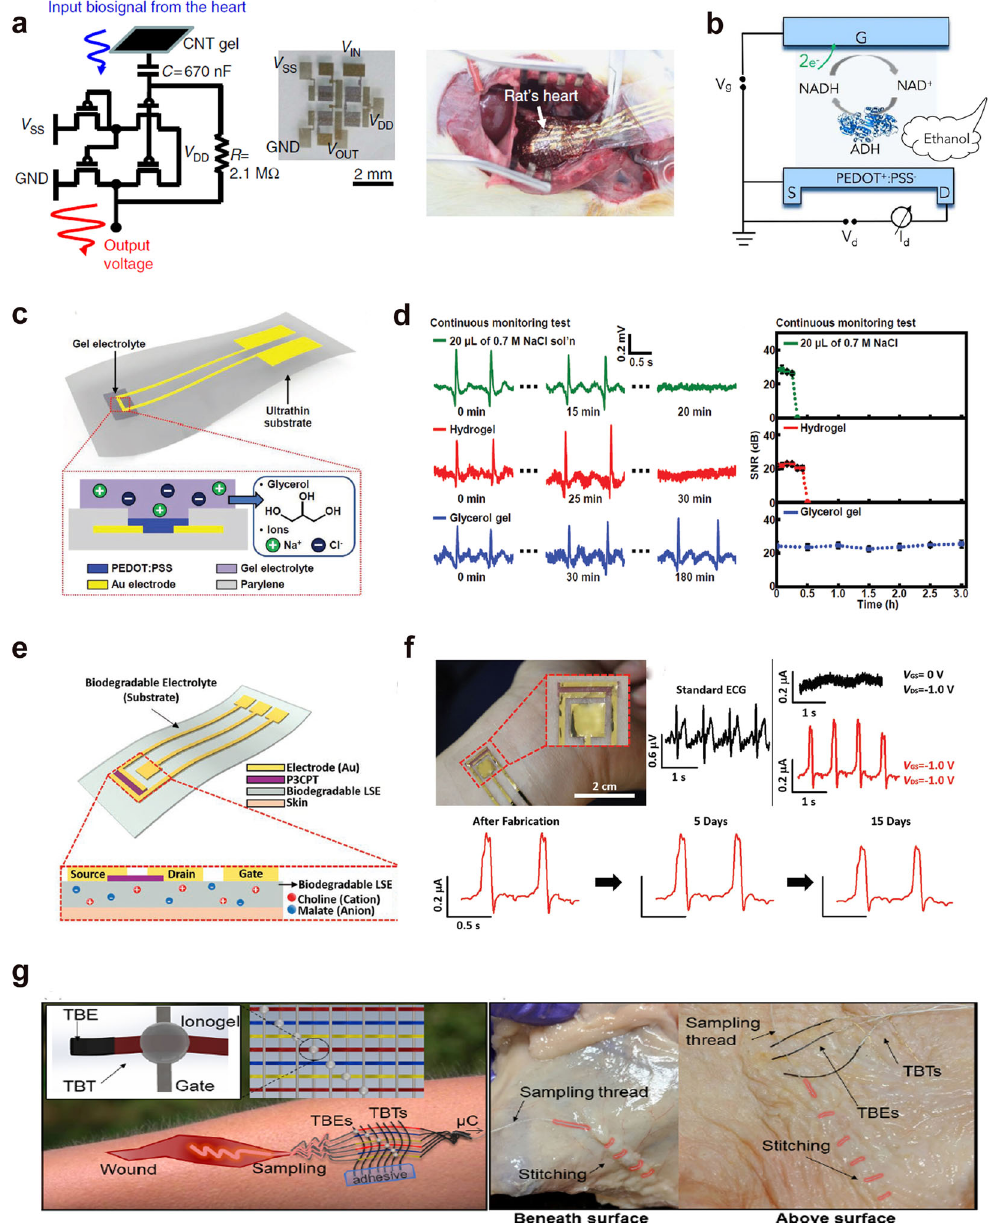
Fig. 6 Bio-sensors made of ionic-gel transistor. a Circuit diagram of a unit of an organic ampli fi er with a conductive gel for an in vivo electrocardiograph and Pictures of an ultra- fl exible circuit on a rat ’ s heart. Reproduced with permission 102 . Copyright 2016, Springer Nature. b Enzymatic reaction of ethanol and ADH in an electrolyte. Reproduced with permission 104 . Copyright 2016, Springer Nature. c Schematic diagram of OECT in a nonvolatile gel electrolyte containing glycerol and ions. d OECT-based sensors measured ECG data at different electrolytes (0.7 m NaCl, hydrogels, and glycerin gels) Reproduced with permission 108 . Copyright 2019, Wiley-VCH. e Schematic of a biodegradable organic transistor. f Standard equipment and biodegradable organic transistors record the ECG signals from the human skin. Reproduced with permission 59 . Copyright 2020, Wiley-VCH. g Schematic diagram of a thread-based integrated transistor system for advanced sensing of bio-related ions. Reproduced with permission 40 . Copyright 2019, American Chemical as the dielectric materials to prepare neuromorphic memtransistor of the gate closer to the channel layer contributes more elements 25 . By de fi ning different gate voltages as different signi fi cantly to the weight of the transistor. The mapping of distance and EPSC contribution is shown in Fig. 7c. They present harmful inputs, they successfully used IGTs to simulate the EPSC current diagrams for different stimulation directions and the modulation of the salient weight of pain receptors. Similar to I/O relationship between the rate coding scheme and neurons in bio-nociceptors, the satellite threshold adjusting receptors (STARs) different directions. They further veri fi ed the in fl uence of stimuli can adjust the transfer characteristic curve of the device according directivity on multi-gate neuromorphic transistors (Fig. 7d). to the intensity of the harmful stimulus (V gs ) to make it more Real-time control can be achieved through a programmable sensitive and avoid repeated damage. When V gs is higher than the circuit design. John et al. also utilized P(VDF-HFP) and [EMIM][TFSI] threshold voltage and the duration increases, signi fi cant transistor